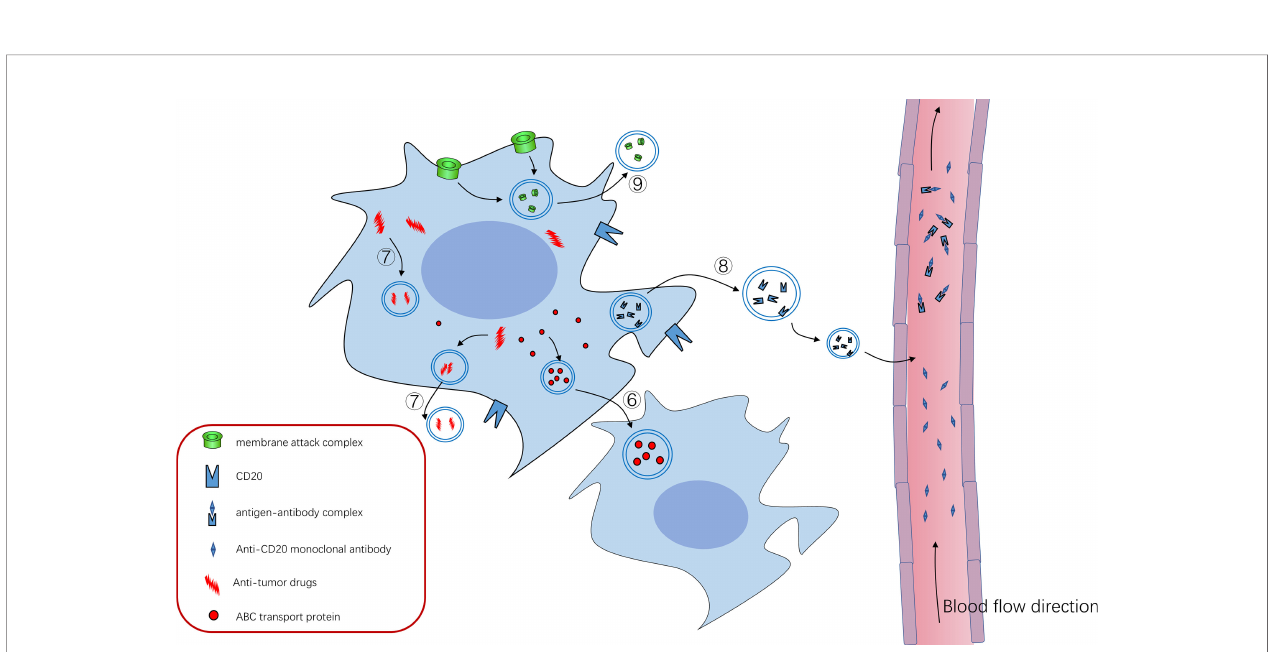
FIGURE 2 | ⑥ ABC transporter can mediate the formation of exosomes and drug resistance of tumor cells, and ABC transporter can be “ shared ” among tumor cells through exosomes to promote tumor progression ⑦ Tumor cells can use exosomes to isolate or excrete intracellular antitumor drugs to achieve therapeutic resistance ⑧ CD20 exists on the cell membrane of B cells, and anti-CD20 Rituximab can bind to CD20 to kill tumor cells. Tumor cells use exosomes to package some CD20 as decoy to release cells, which combine with anti-CD20 Rituximab to reduce their bioavailability and protect tumor cells from killing effects ⑨ Tumor cells use exosomes to expel the membrane attack complex (MAC) inserted into the cell membrane to the outside of the cell, reducing its killing